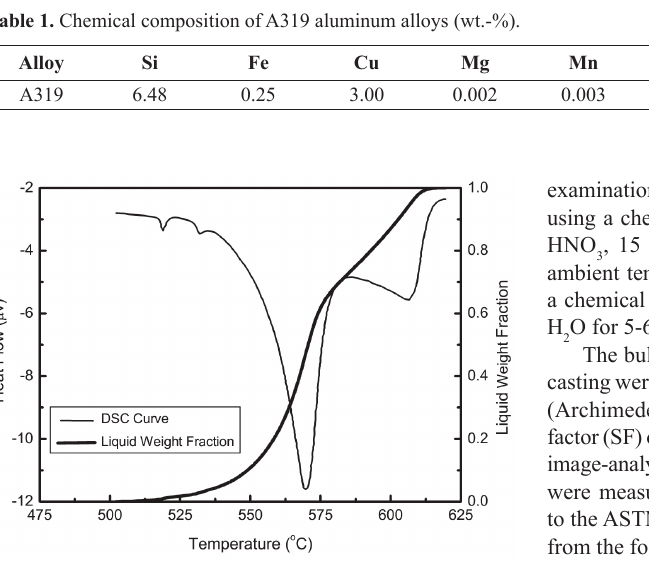
Figure 1. DSC and liquid weight fraction versus temperature curves for A319